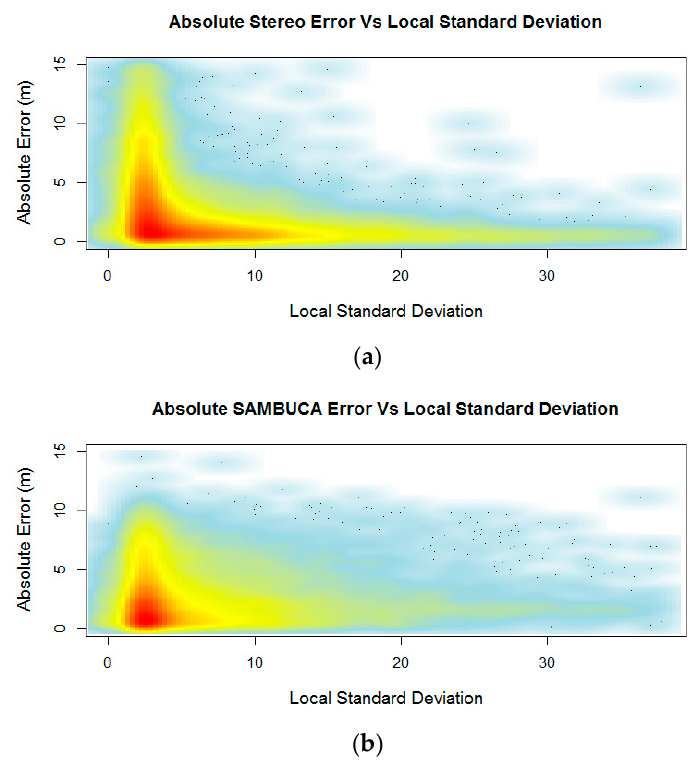
Figure 9. Density plots of ( a ) stereo accuracy versus standard deviation and ( b ) SAMBUCA accuracy versus standard deviation.